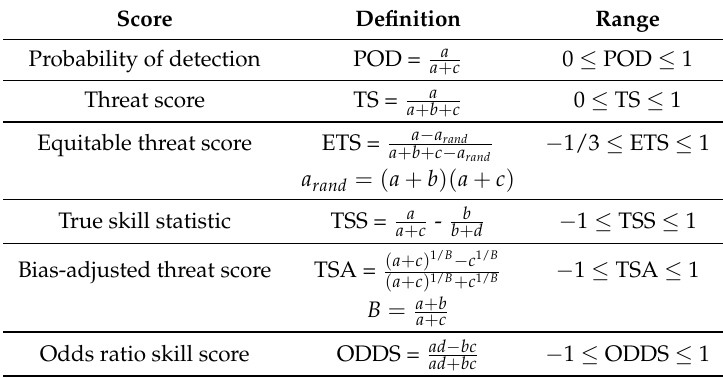
Table 6. Definition of performance